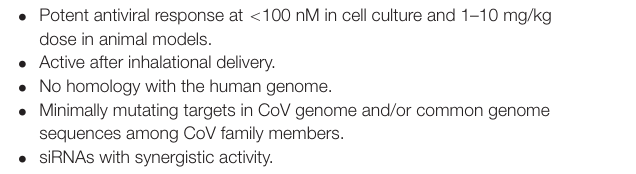
TABLE 1 | Desirable features of siRNA agents for SARS-CoV-2